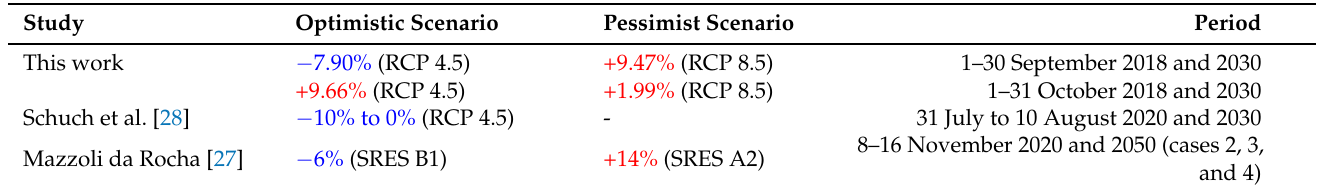
Table 4. Comparison between changes in ozone concentration and other similar studies for the MASP under climate change scenarios.